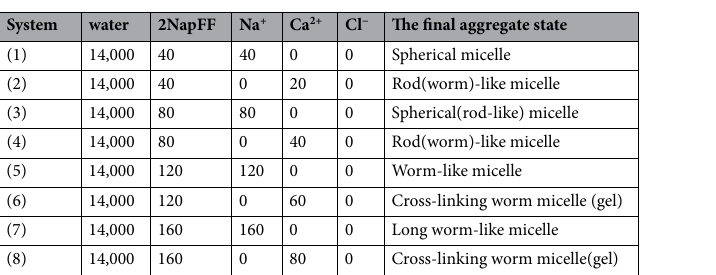
Table 1. The detailed compositions and the final aggregate